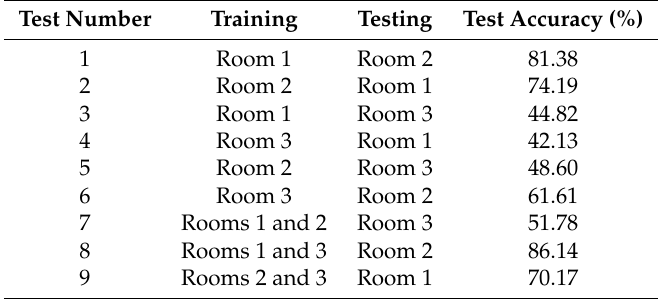
Table 8. Accuracies of the nine di ff erent models trained for the various combinations of the three rooms.